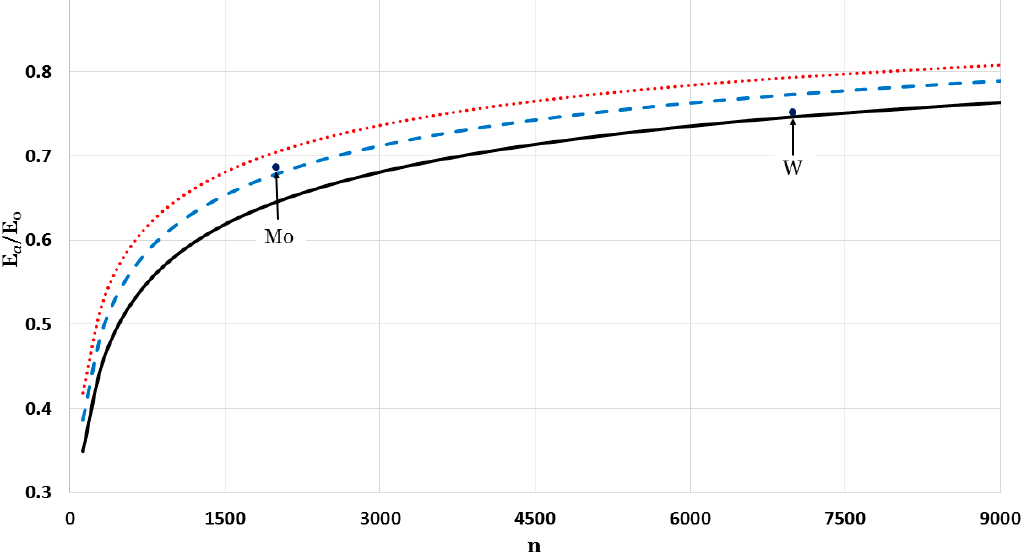
Figure 8. The variation of the relative cohesive energy of nanoparticles in a face-centered cubic structure as function of the number of atoms for (cid:1865) = 3 and different values of (cid:2009) : 2.0 (black solid line), 2.1 (blue dashed line), and 2.2 (red dotted line). The experimental values [23,24] are denoted by dark blue circles.